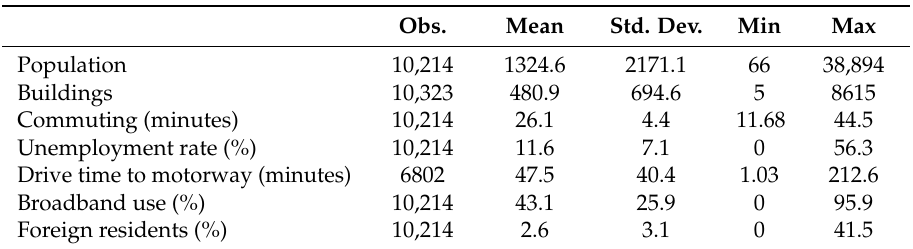
Table 3. Summary